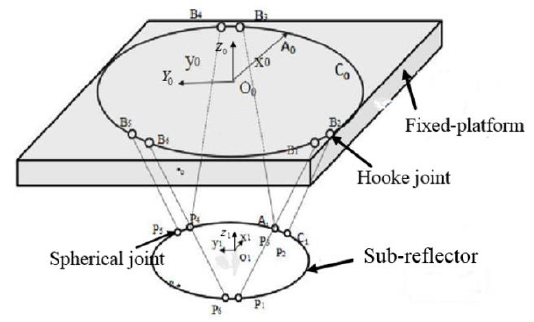
Figure A1. The coordinate systems of the fixed platform and the sub-reflector.